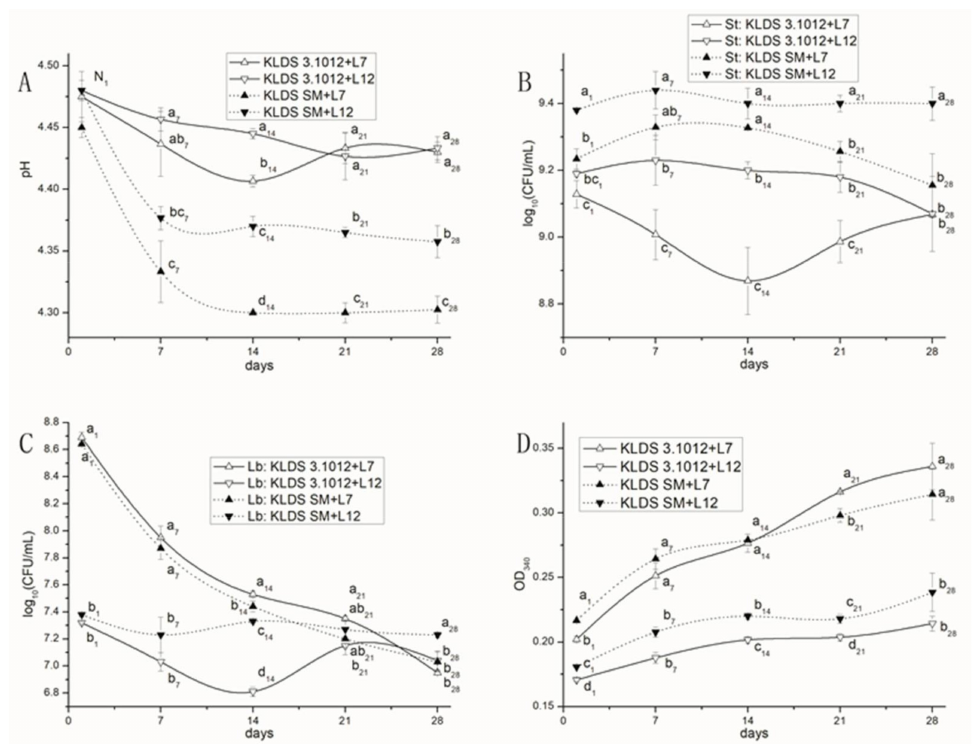
Figure 7. Comparison of industry properties of the four mixed cultures during cold storage: ( A ) pH curves of yoghurt produced by the four combinations during cold storage; ( B ) Survival of S. thermophilus in mixed culture; ( C ) Survival of Lb. bulgaricus in mixed culture; and ( D ) Proteolysis (OD340 nm) of yoghurt during cold storage. N1: no significant difference at 1st